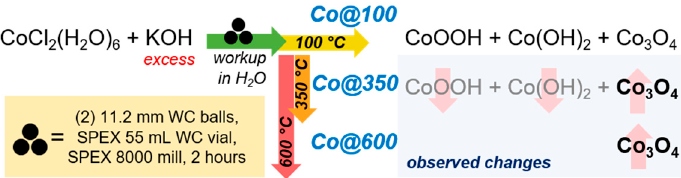
Figure 2. General protocol for the preparation of Co@100, Co@350, and Co@600.